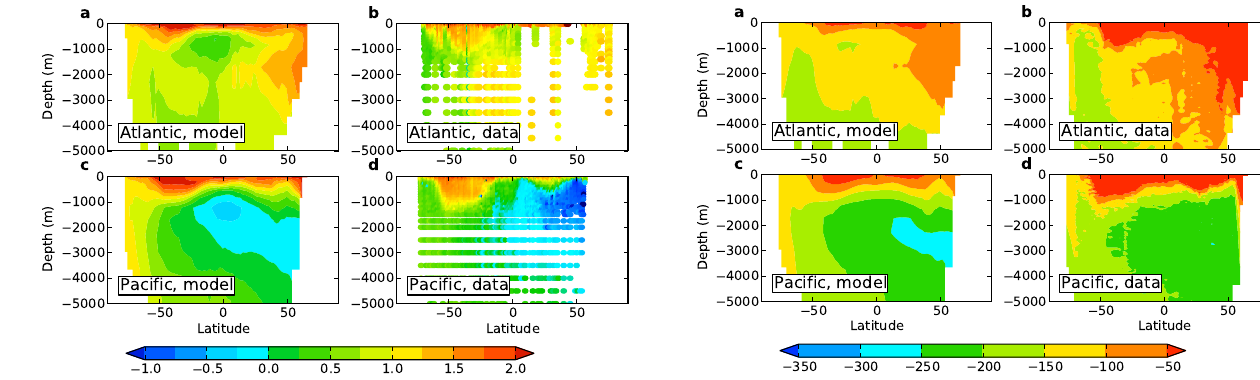
Figure 19. Zonal average of the (cid:49) 14 C distribution in the ocean (‰). Data from GLODAP (Key et al.,